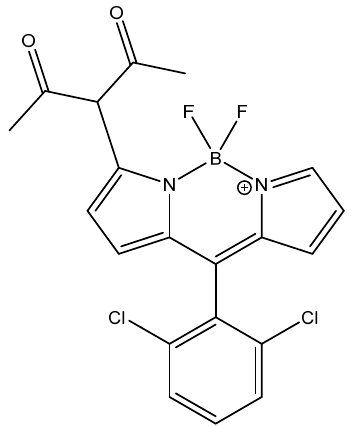
Figure 7. Modified BODIPY. The keto-form is shown; however, an equilibrium exists between the enol and keto-form.